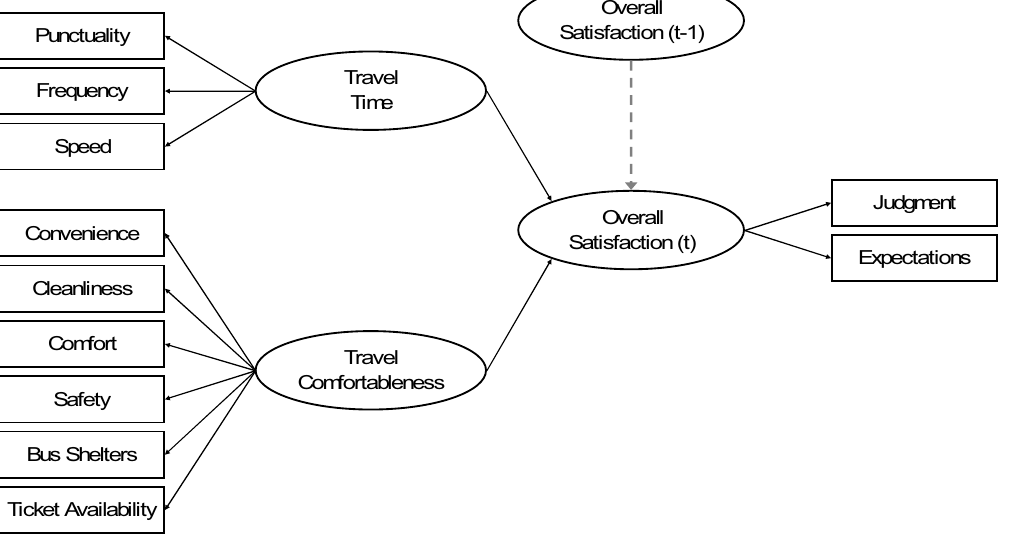
Figure 8 – The path diagram at time